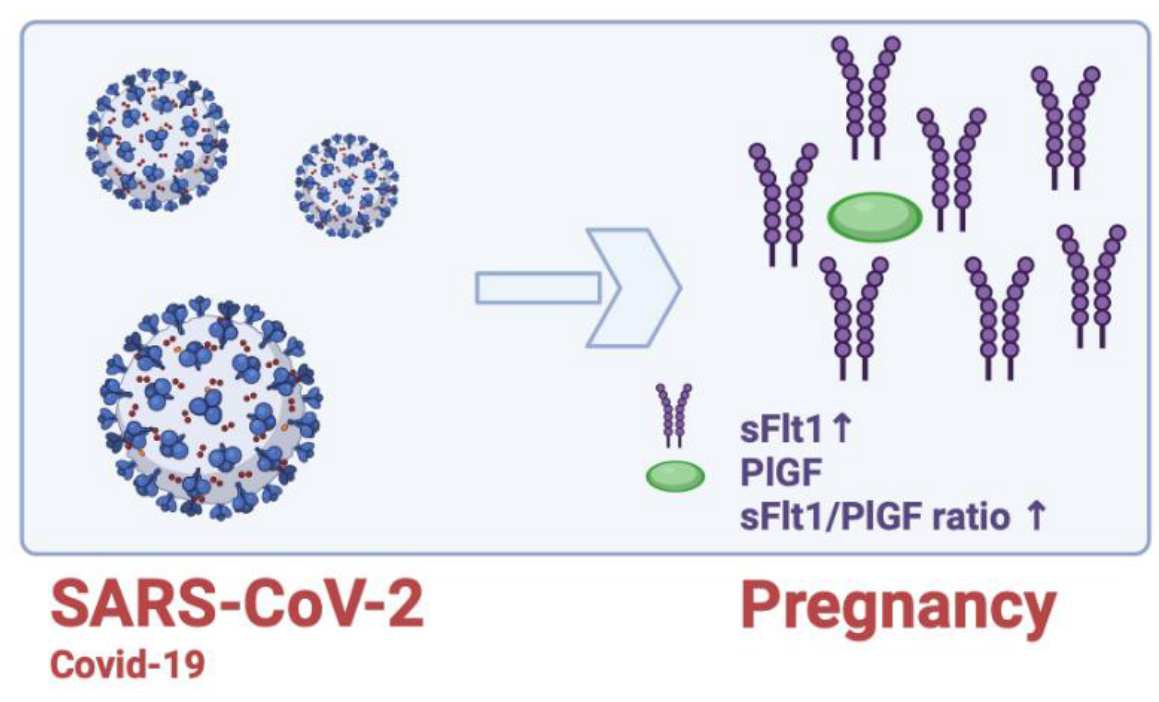
Figure 5. Impact of COVID-19 on the sFlt1/PlGF Ratio.